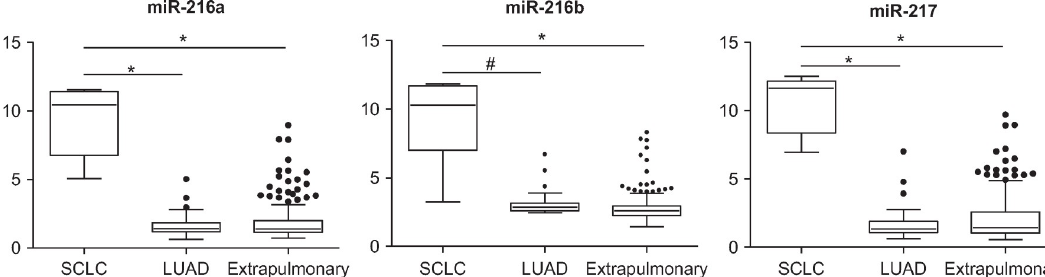
Fig 3. Discriminatory microRNAs for small cell lung cancer. Discriminatory microRNAs comprising the node no. 6 of the decision tree that differentiate small cell lung cancer (SCLC) from primary lung adenocarcinoma (LUAD) and extrapulmonary cancers ( � p < 10 − 10 ; #p = 2 x 10 − 9 ; t-